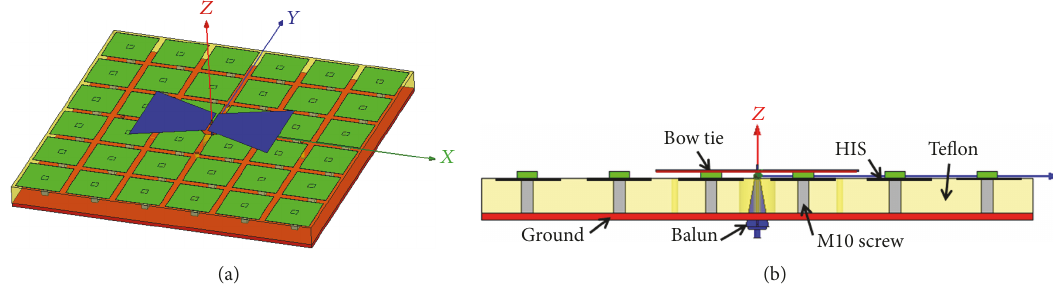
Figure 3: Low-profile bow tie antenna: (a) 3D view and (b) cross-sectional view.